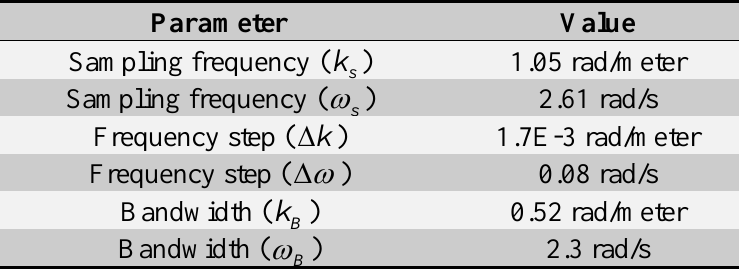
Table 1. Parameters for generation of the folded